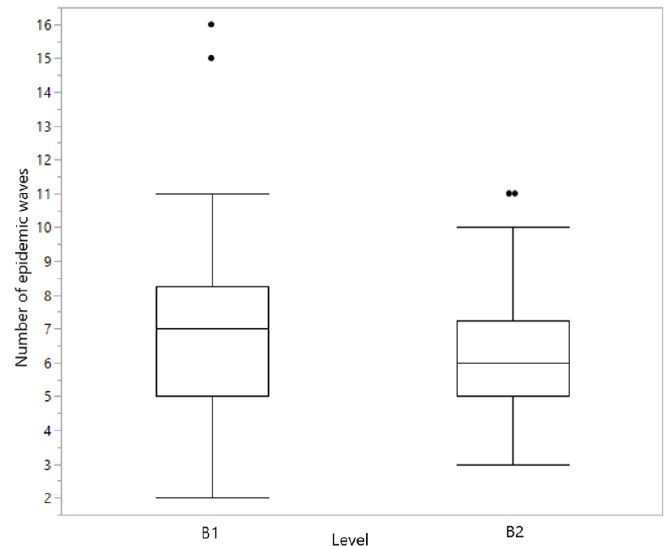
Figure 6. Boxplot of total number of epidemic waves.